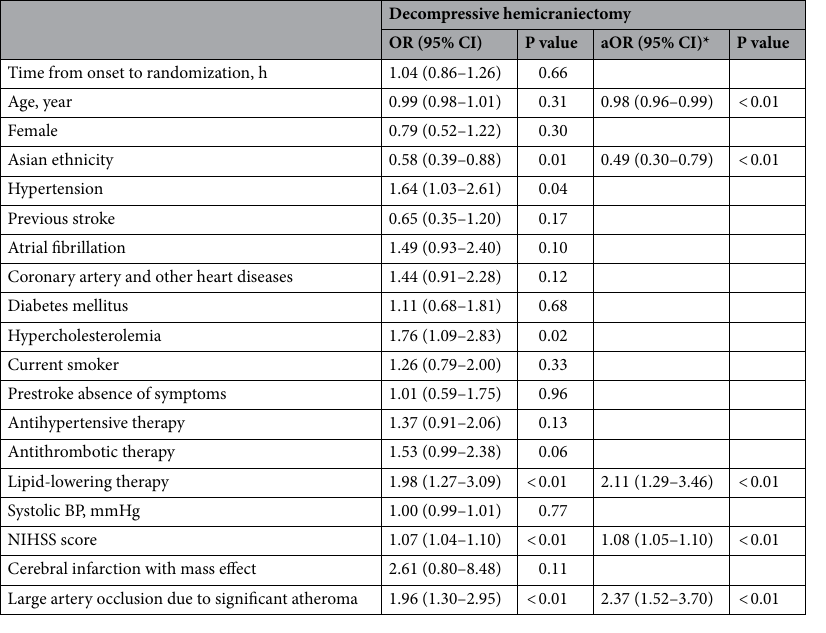
Table 2. Independent predictors associated with decompressive hemicraniectomy. aOR adjusted odds ratio, BP blood pressure, CI confidence interval, NIHSS National Institute of Health Stroke Scale, OR odds ratio. *Included all significant variables in univariable analysis, and age, sex, and Asian ethnicity.